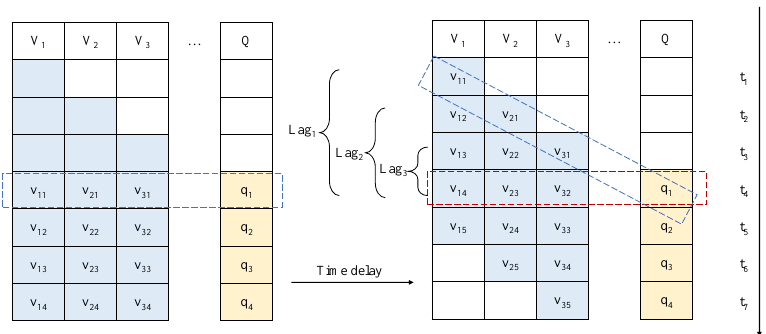
Figure 2. Multiple time